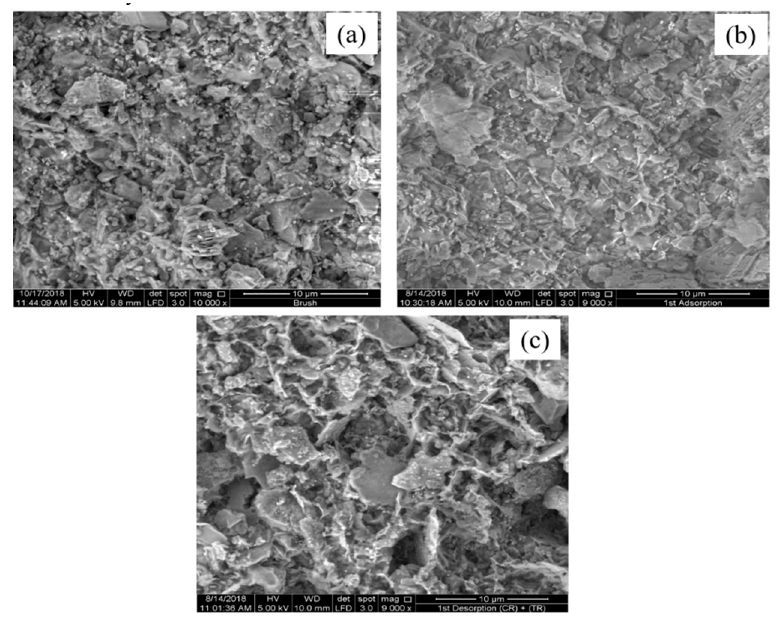
Figure 9. Scanning electron micrograph of the ( a ) adsorbent before adsorption, ( b ) adsorbent after adsorption of MB and ( c ) adsorbent after desorption of MB.